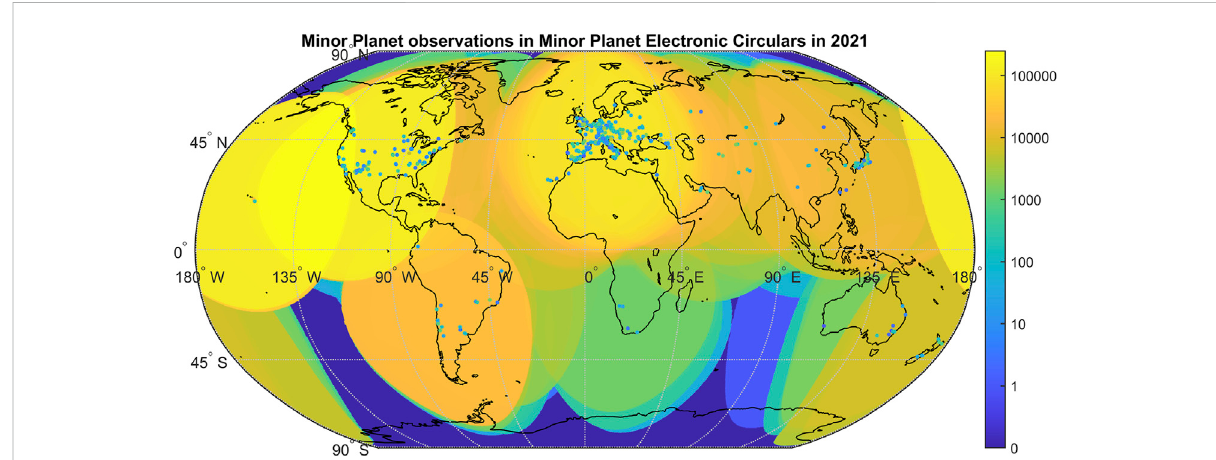
FIGURE 1 Number of observations published in the Minor Planet Electronic Circulars (MPECs) in 2021. The individual MPC observatories are mapped as points on their geographic coordinates with their number of observations as color. Observatories with no observations in 2021 are removed. The cumulated observations within an arc of 45 ° of the geographic coordinates is